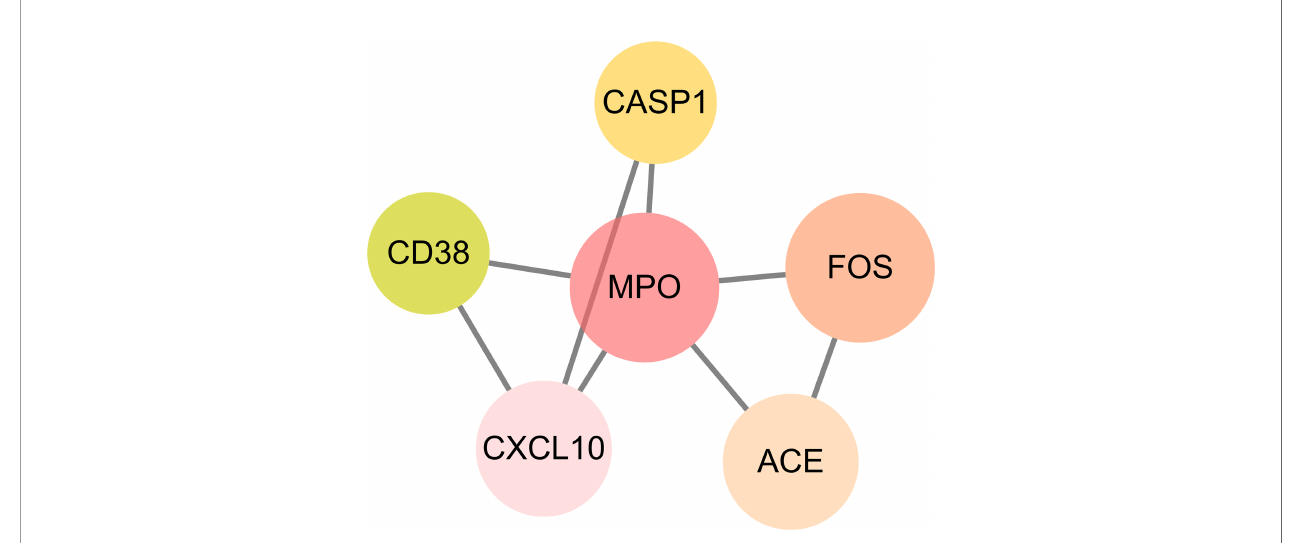
FIGURE 7 | Identi fi cation of all core drug targets in luteolin in treating PC and